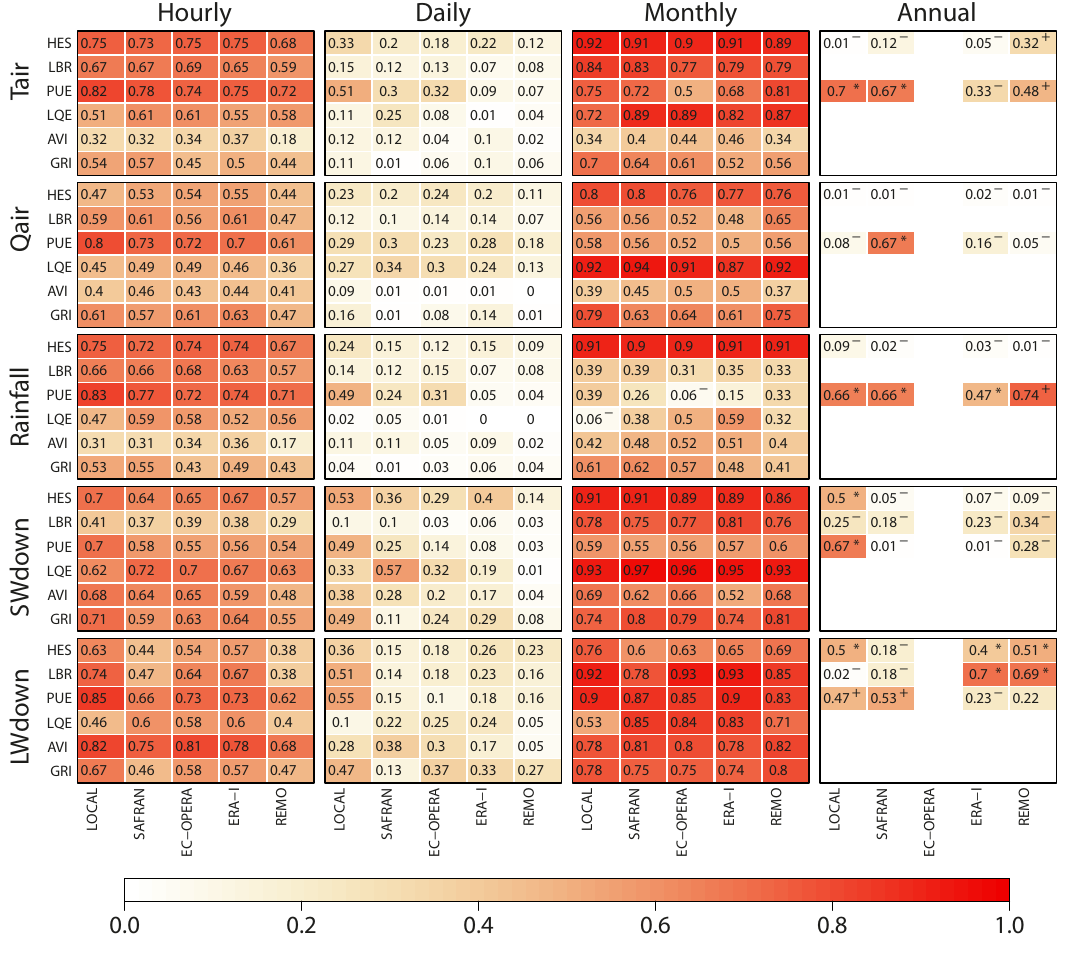
Fig. 6. Squared correlation ( R 2 ) between simulated and measured flux data and in situ data over 2004 to 2007, except for EC-OPERA which covers 2004–2006. Panels of R 2 from left to right are for hourly, daily, monthly and annual time scales, respectively. Time series used to calculate R 2 correspond to growing season. For crop sites, we only take the years of winter wheat growing; that is, 2004 and 2006 at AVI, and 2006–2007 at GRI. The default statistical confidence level of R 2 is p < 0 . 01. Otherwise, the signal at the upper-right indicates a confidence level: “*” for p < 0 . 05, “+” for p < 0 . 10, and “–” for p > 0 .